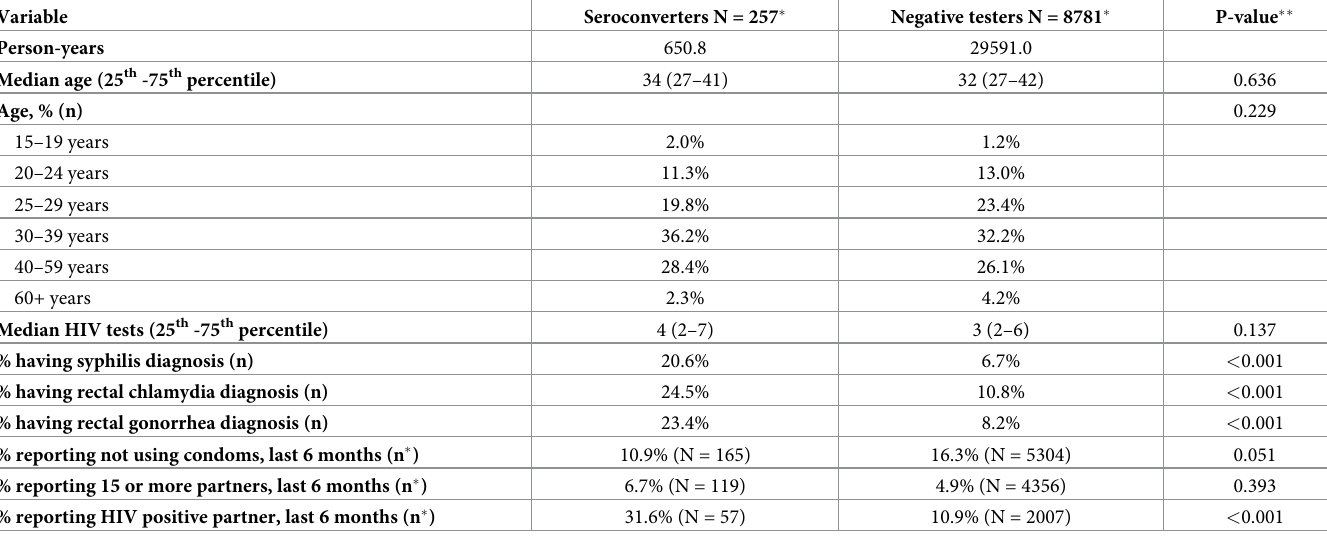
Table 1. Summary statistics describing the study cohort, comparing HIV seroconverters to negative HIV testers, 2004 to 2017. Variable Seroconverters N = 257 � Negative testers N = 8781 �